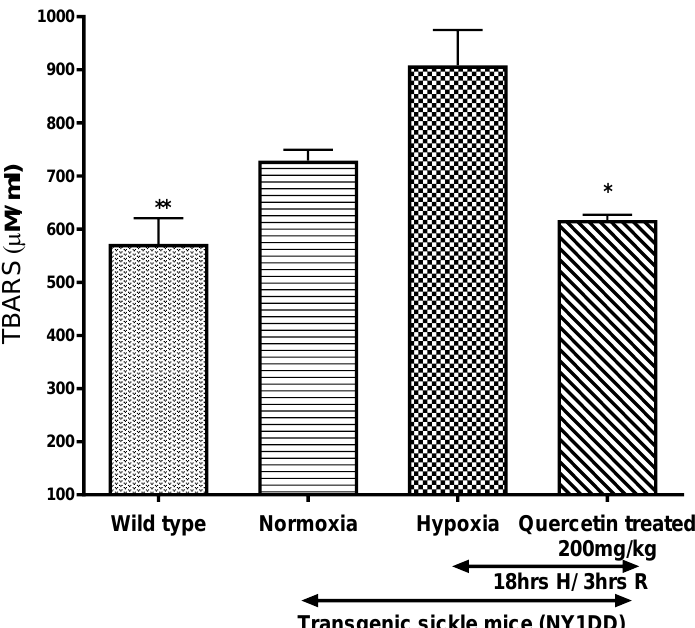
Figure 6. Effect of single dose of quercetin (200 mg/kg, i.p.) on thiobarbituric acid reactive substances (TBARS) in wild type and NY1DD transgenic sickle mice under normoxia and hypoxia conditions. Values represent the mean ± SEM for four animals in each group; ** p < 0.01 vs. hypoxia NY1DD mice; * p < 0.028 as compared to H/R-induced NY1DD mice.